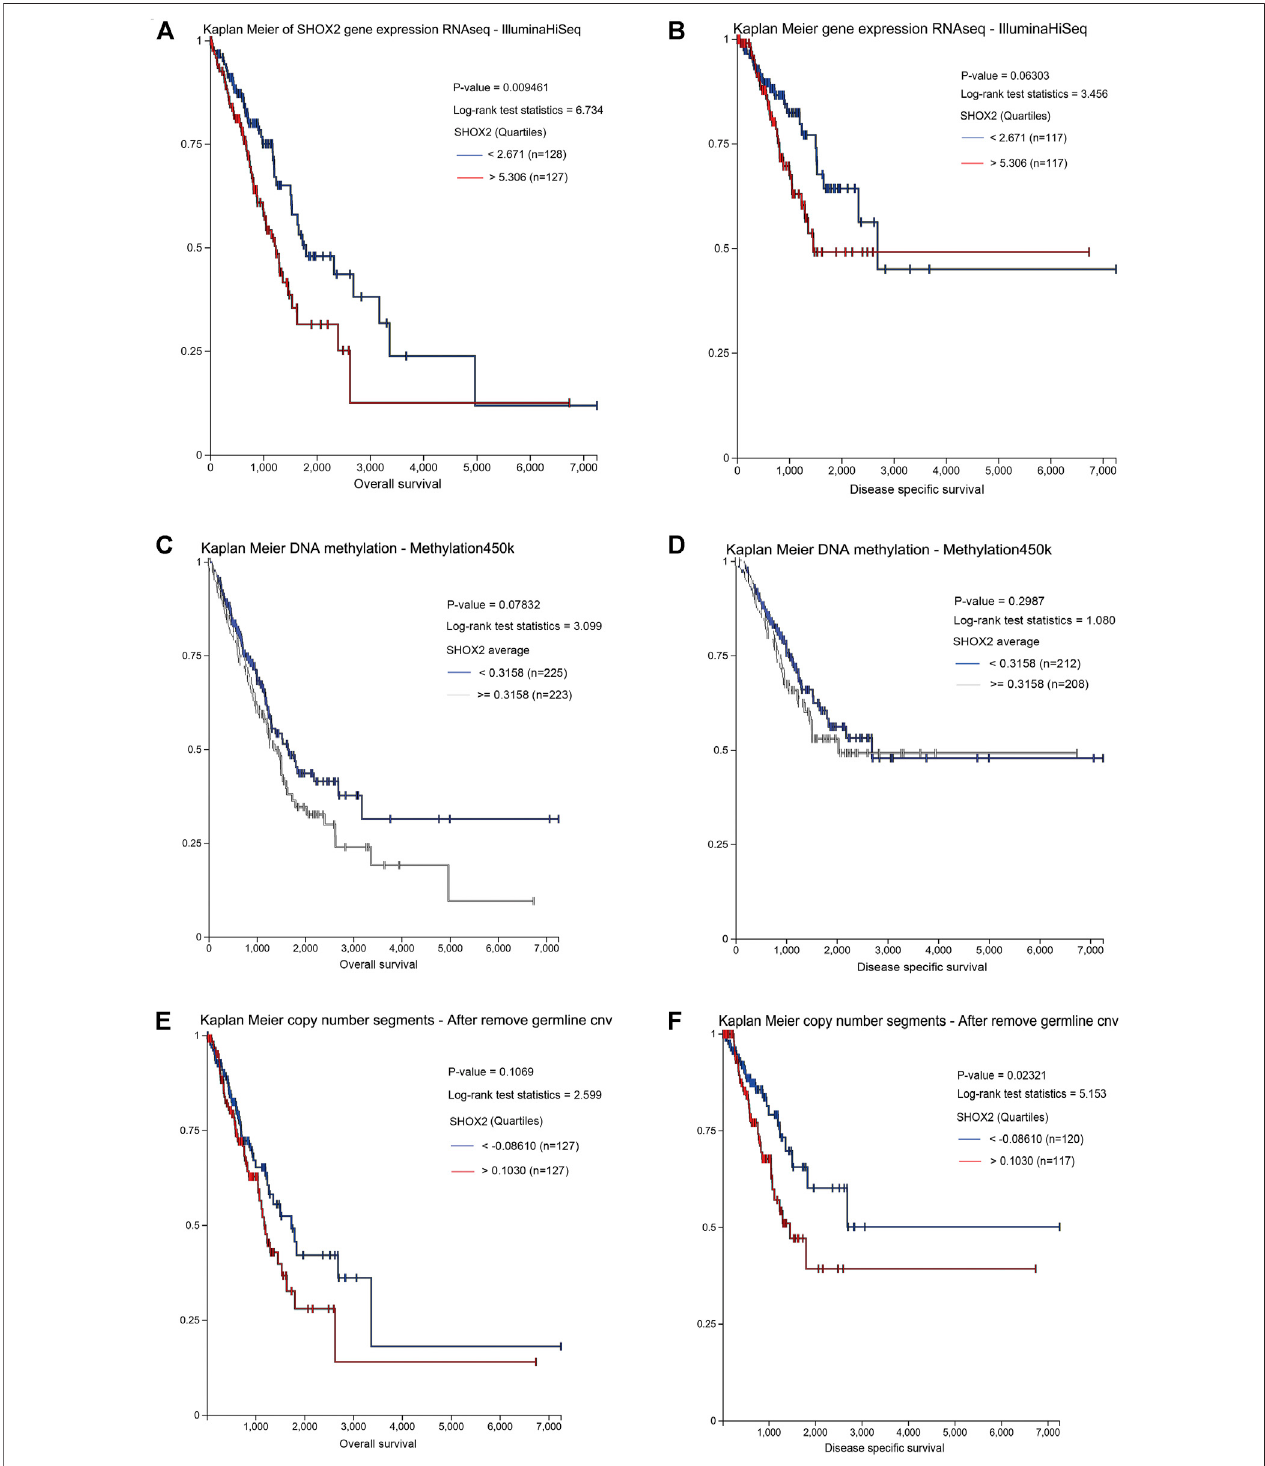
FIGURE 4 | Prognostic value of the SHOX2 mRNA expression level in LUAD patients by UCSC Xena (Kaplan – Meier plotter). (A) Relationship between SHOX2 expression and OS in LUAD. (B) Relationship between SHOX2 expression and DSS in LUAD. (C) Relationship between SHOX2 DNA methylation and OS in LUAD. (D) Relationshipbetween SHOX2 DNAmethylationandDSSinLUAD. (E) Relationship between SHOX2 copynumbersegmentsandOSinLUAD. (F) Relationshipbetween SHOX2 copy number segments and DSS in LUAD. p < 0.05 indicates statistical signi fi cance. LUAD: lung adenocarcinoma; OS: overall survival; DSS: disease- speci fi c survival.